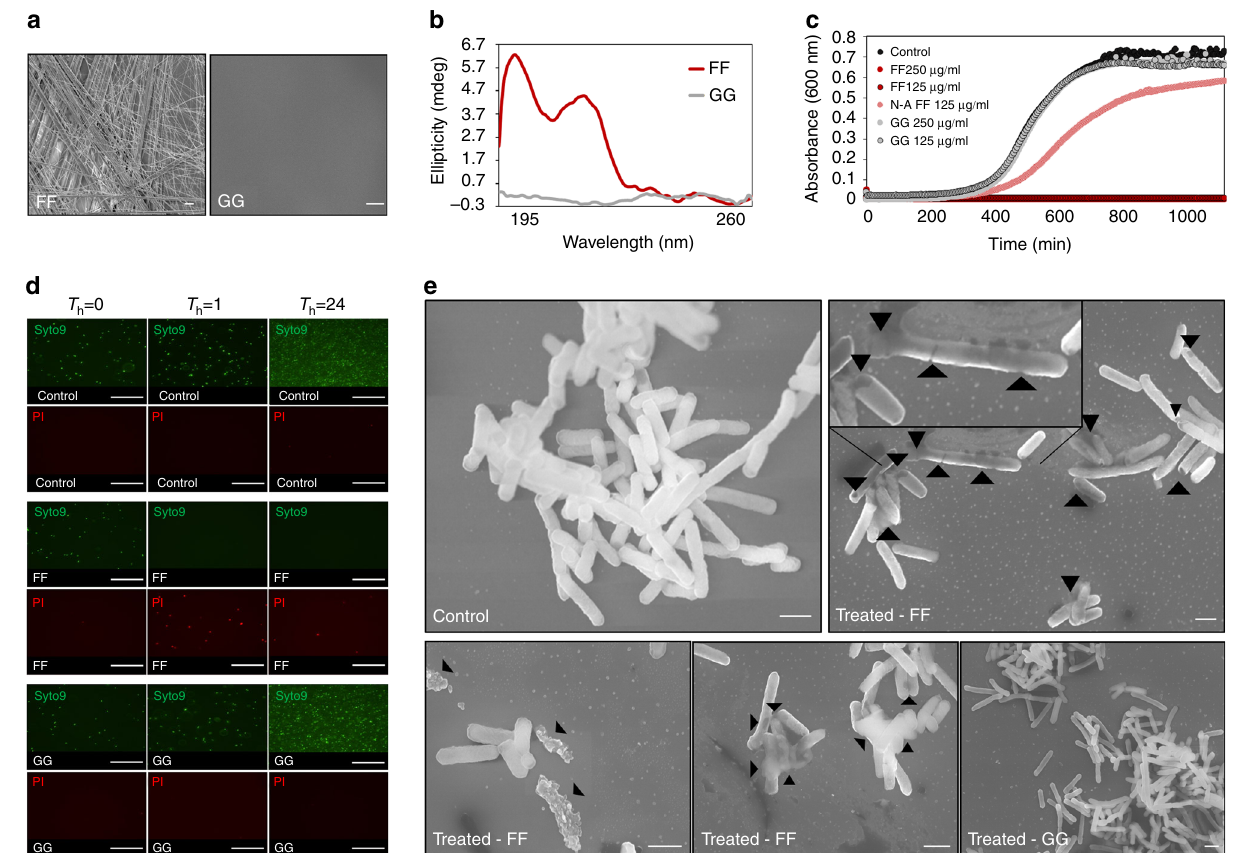
Fig. 1 The diphenylalanine nanostructures hinder E. coli growth and viability and severely damage bacterial morphology. a Morphology of the nanostructures formed by the studied peptides. Micrographs were obtained via scanning electron microscopy. Scale bar is 10 µ m. b Secondary structure of the studied peptides as obtained by circular dichroism (CD). CD spectra were obtained for both of the peptides diluted in ultra-pure water at 25°C. c Kinetics of the inhibition of bacterial growth. The effect of the diphenylalanine nanostructures and controls on bacterial growth was evaluated by turbidity analysis via absorbance readings at 600nm of bacteria treated overnight. d Effect of the diphenylalanine nanostructures on bacterial viability. Bacterial viability was evaluated using the Live/Dead backlight bacterial viability kit. Green fl uorescence of the Syto9 probe indicates bacterial cells with an intact membrane, while red fl uorescence of Propidium Iodide (PI) indicates dead bacterial cells. Scale bar is 50 µ m. e Evaluation of the effect of the diphenylalanine nanostructures on bacterial morphology. Micrographs were obtained using a high-resolution scanning electron microscope. Scale bar is 1 µ